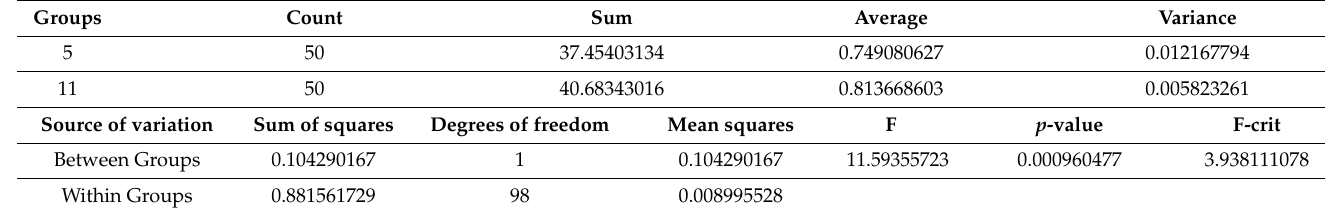
Table 6. ANOVA analysis of the model accuracy for models trained with 5 and 11 cultivation data for the shock stage.